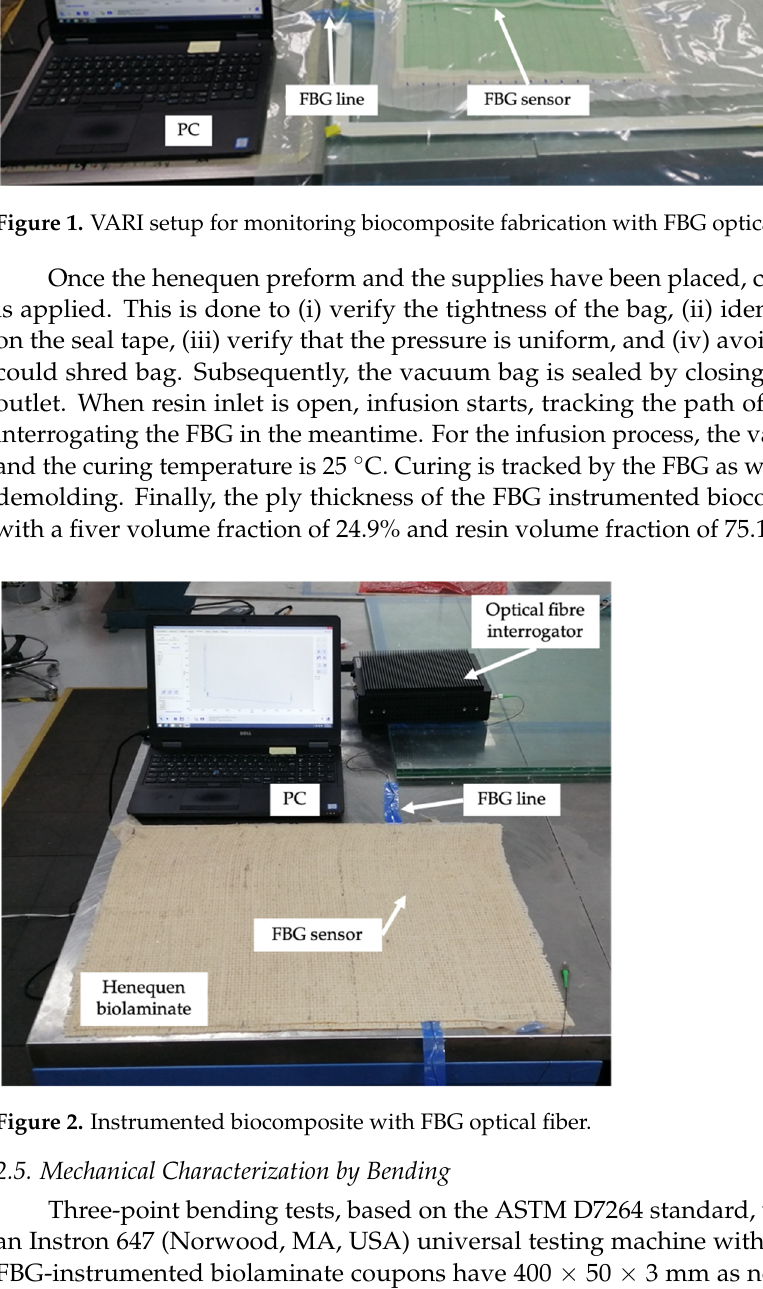
Figure 2. Instrumented biocomposite with FBG optical fiber.